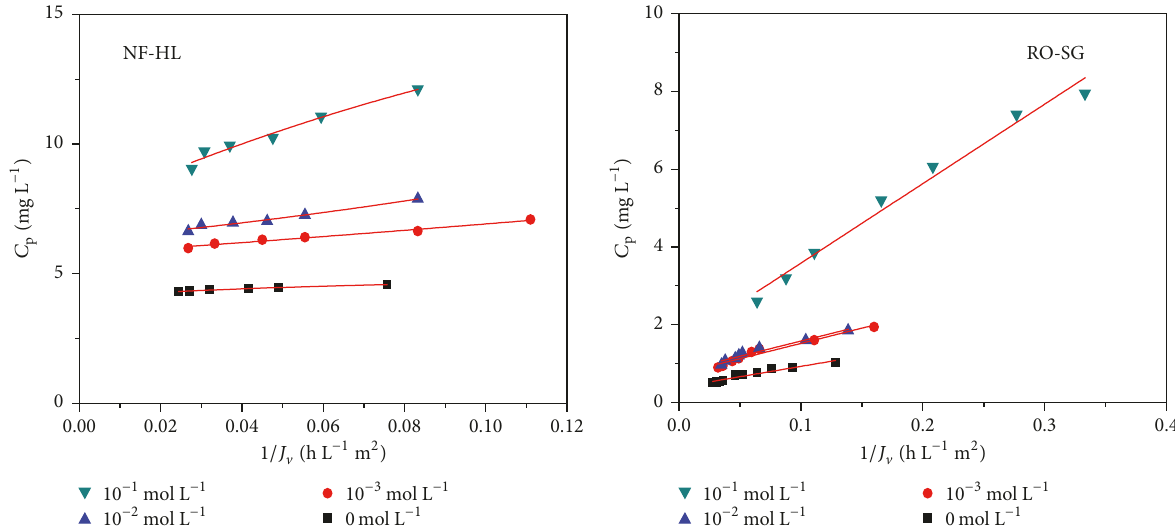
Figure 5: Variation of the permeate concentration in function of 1/𝐽 V of Cr(VI) at different KCl concentrations ( 𝐶 Cr ( VI ) = 50 mgL −1 , 𝑌 = 50%, pH = 8, and 𝜃 = 25 ∘